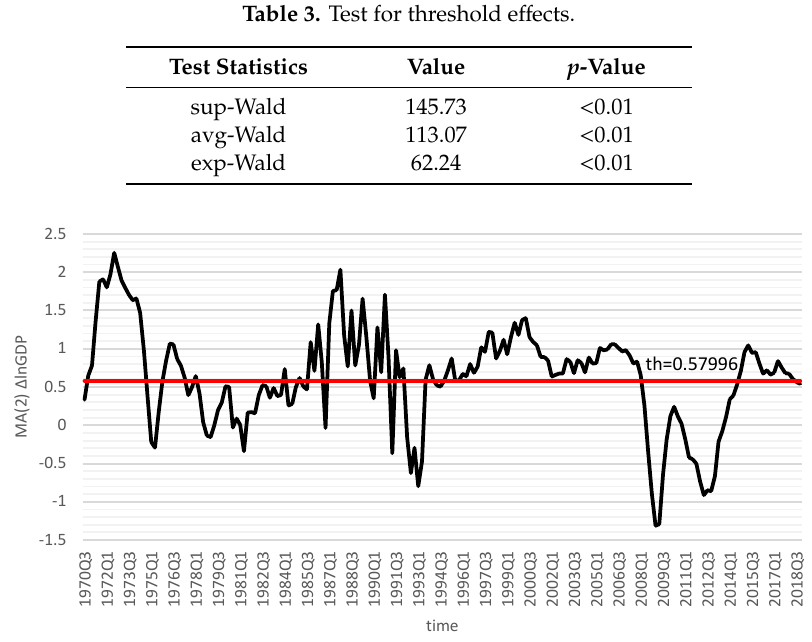
Figure 2. Transition variable (two-quarter moving average of ΔlnGDP) and threshold value.